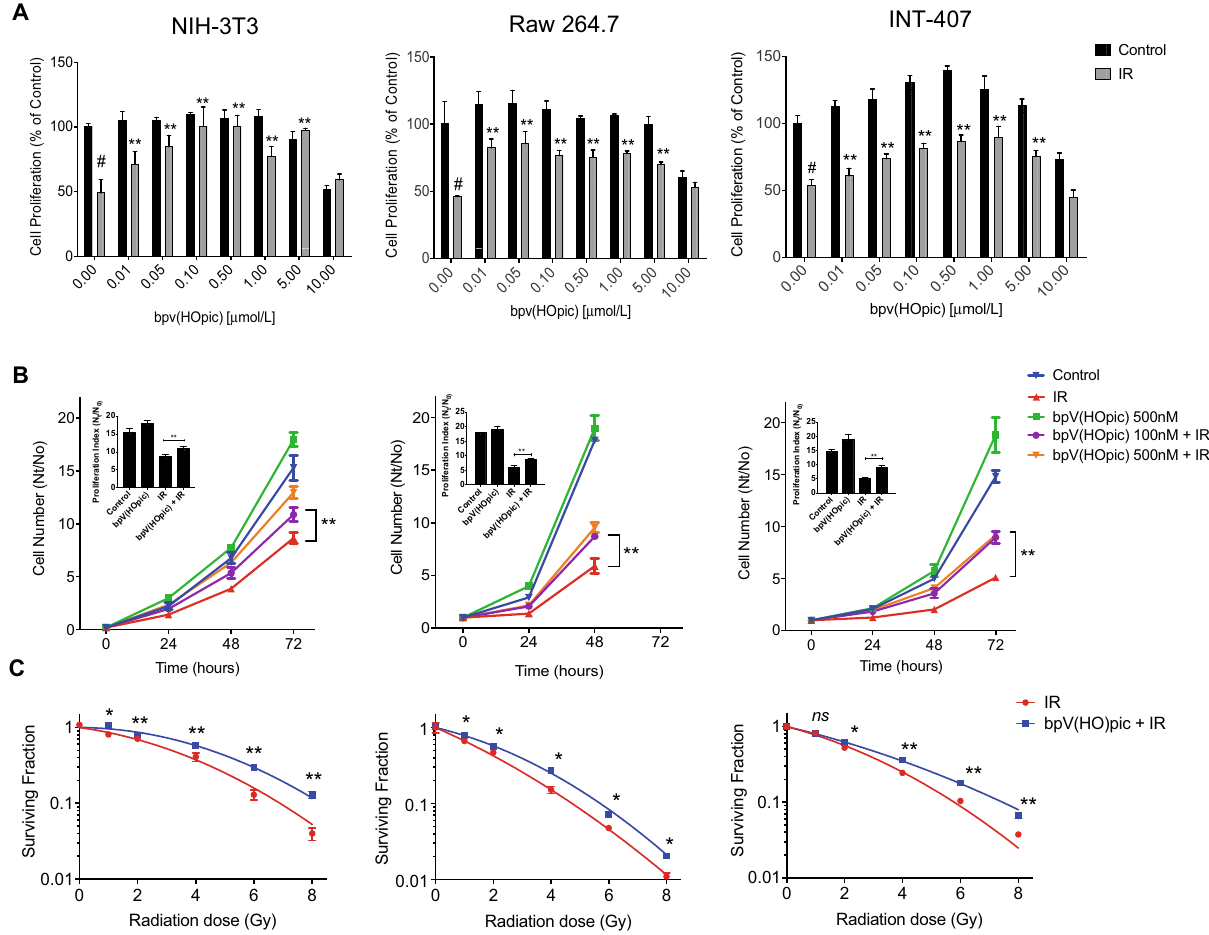
Figure 1. bpV(HOpic) confers radioresistance in cells. ( A ) Effect of bpV(HOpic) on radiation induced cytotoxicity was assessed by SRB assay in NIH-3T3, Raw 264.7 and INT407 cells 48 h post IR exposure. Data presented as cell proliferation % of control. ( B ) Effect of pretreatment of 100 nmol/L and 500 nmol/L concentrations of bpV(HOpic) on the proliferation index (PI)(N t /N 0 ) of irradiated NIH-3T3 (4 Gy), Raw 264.7 (2 Gy) and INT 407 cells (6 Gy). Inset bar charts represents PI of the ultimate timepoint of each cell line. ( C ) Clonogenic survival assay of 100 nmol/L bpV(HOpic) pretreated cells exposed to different doses of irradiation. Surviving fractions of un-irradiated and irradiated samples was calculated by considering the plating efficiency of un-irradiated control as 1. Error bars are mean ± SD, with n = 4. # = IR versus unirradiated control ( p < 0.01) * p < 0.05; ** p < 0.01; ns = non